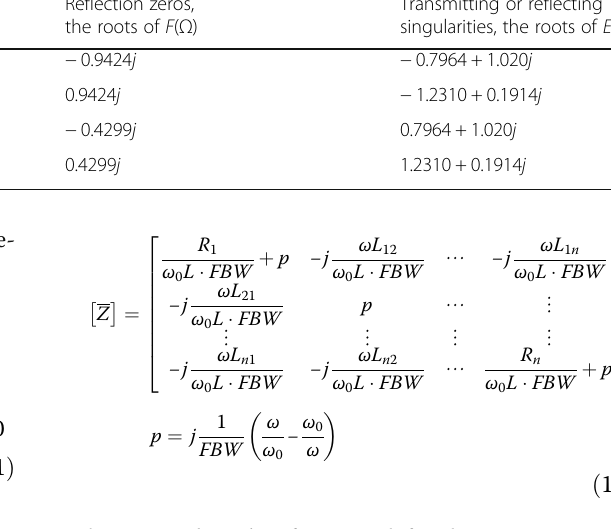
Reflection zeros, the roots of F ( Ω )